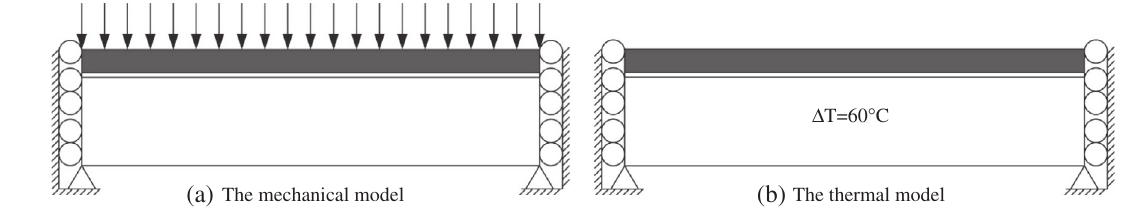
Figure 3. Two load cases of model.